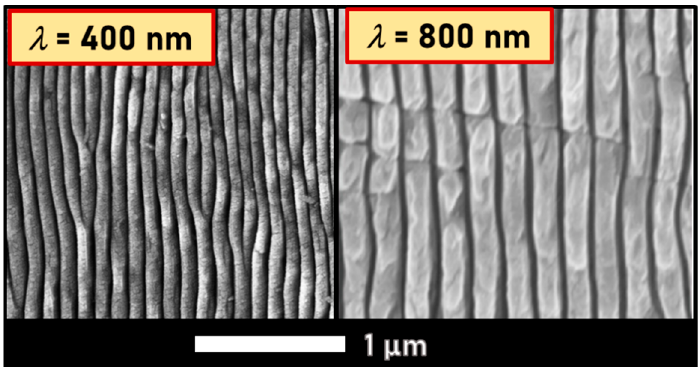
Figure 4. Comparison between SEM images of HSFL obtained with different laser wavelengths on polycrystalline diamonds samples. Linearly polarized pulses, λ = 800 nm, τ = 100 fs.